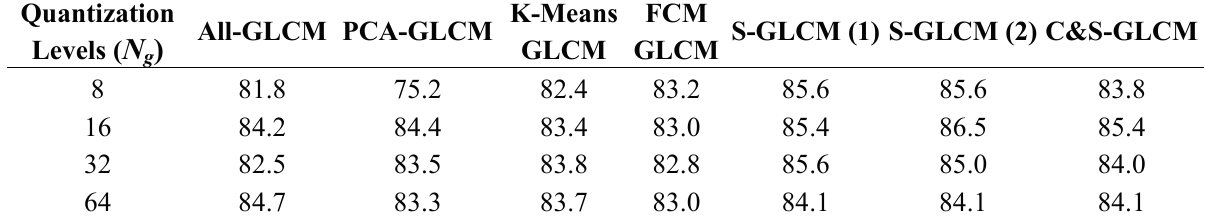
Table 5. The average accuracies (OA%) of each texture classification algorithm with the various quantization levels for the GeoEye-1 Wuhan dataset.